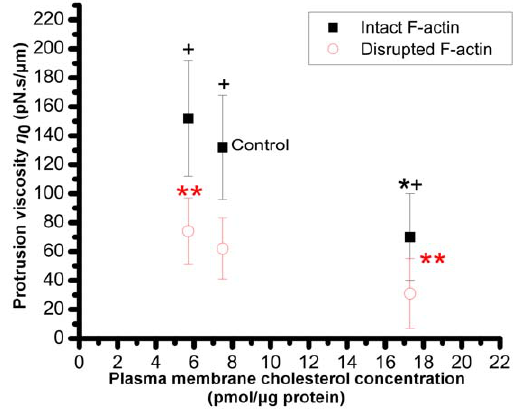
Figure 8. Protrusion viscosity. Effect of membrane cholesterol content on the viscosity coefficient of the protrusion for cells with intact or disrupted F-actin. Asterisk (*) indicates a statistically significant difference with control; ** indicates a statistically significant difference between the two indicated data sets; and + indicates a statistically significant difference between intact F-actin and F-actin disrupted cells at the same cholesterol concentration.